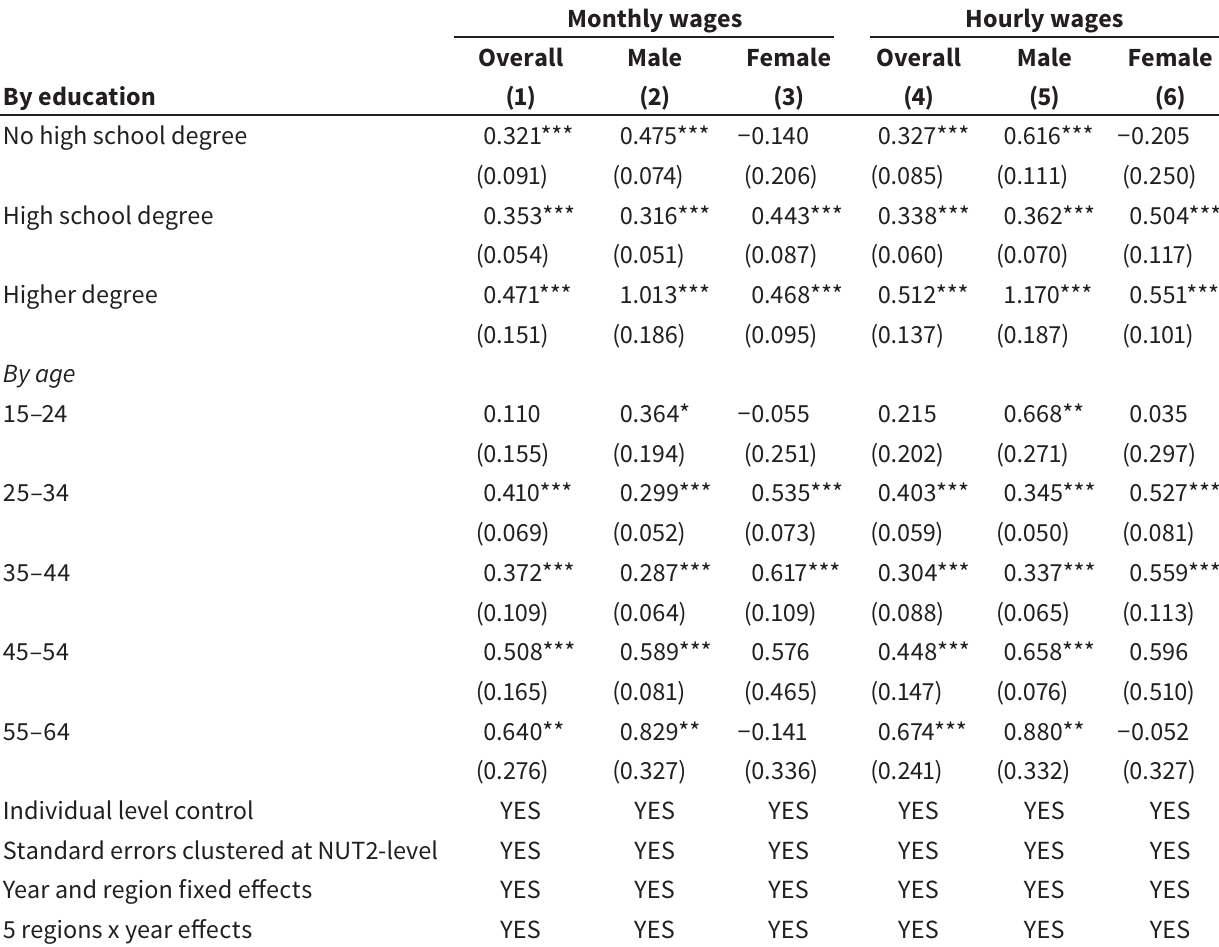
Wage effects, baseline estimation using the baseline fraction affected exposure variable Monthly wages Hourly